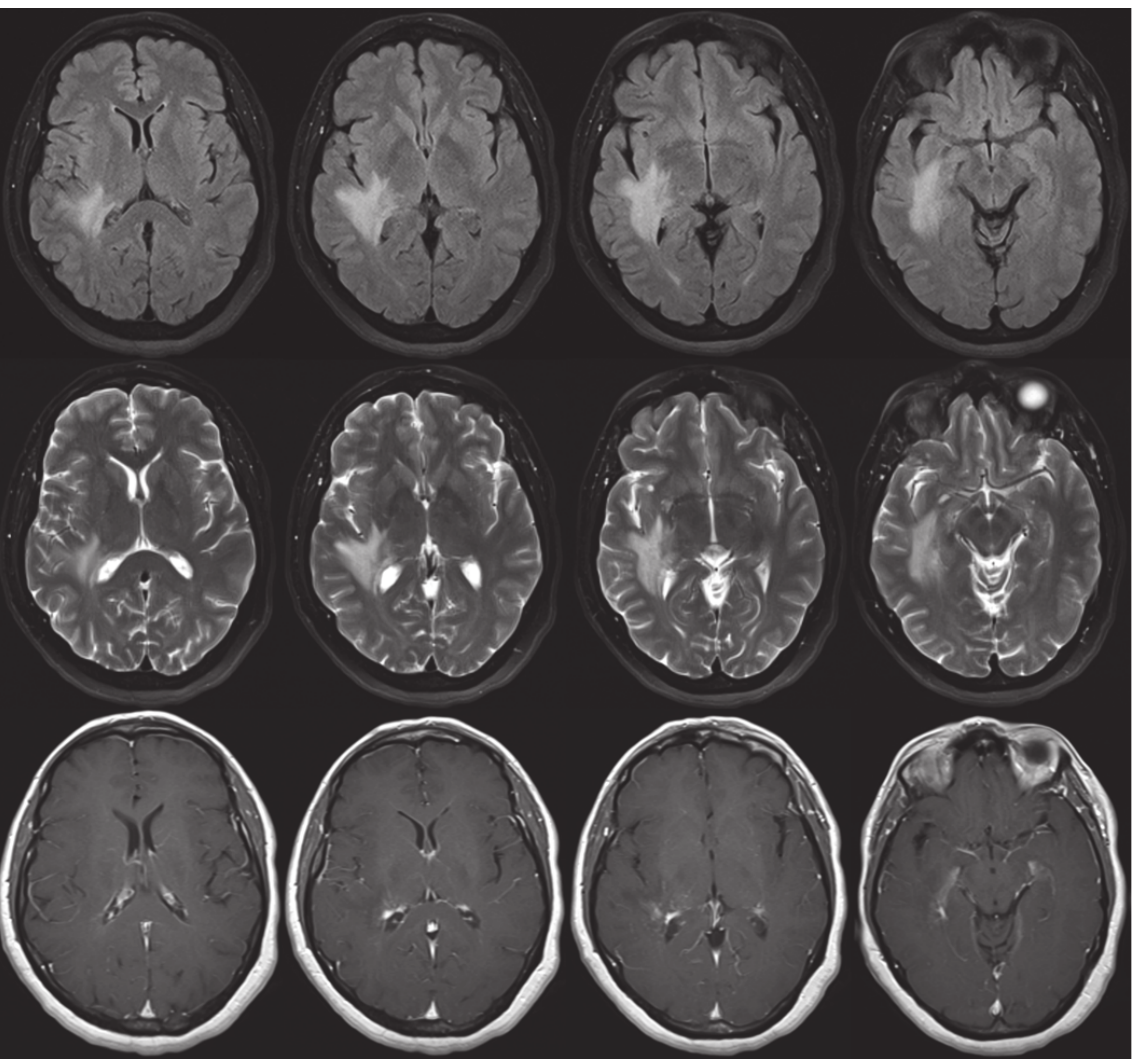
Figure 1: MRI of the brain showing peritrigonal (temporal lobe) deep white matter mass measuring 2.6 × 3.5 cm with surrounding vasogenic edema. There was no restricted diffusion with slightly increased flow at the affected area and normal cerebral blood volume on MR perfusion. Axial and sagittal T1 postgadolinium studies showed minimal